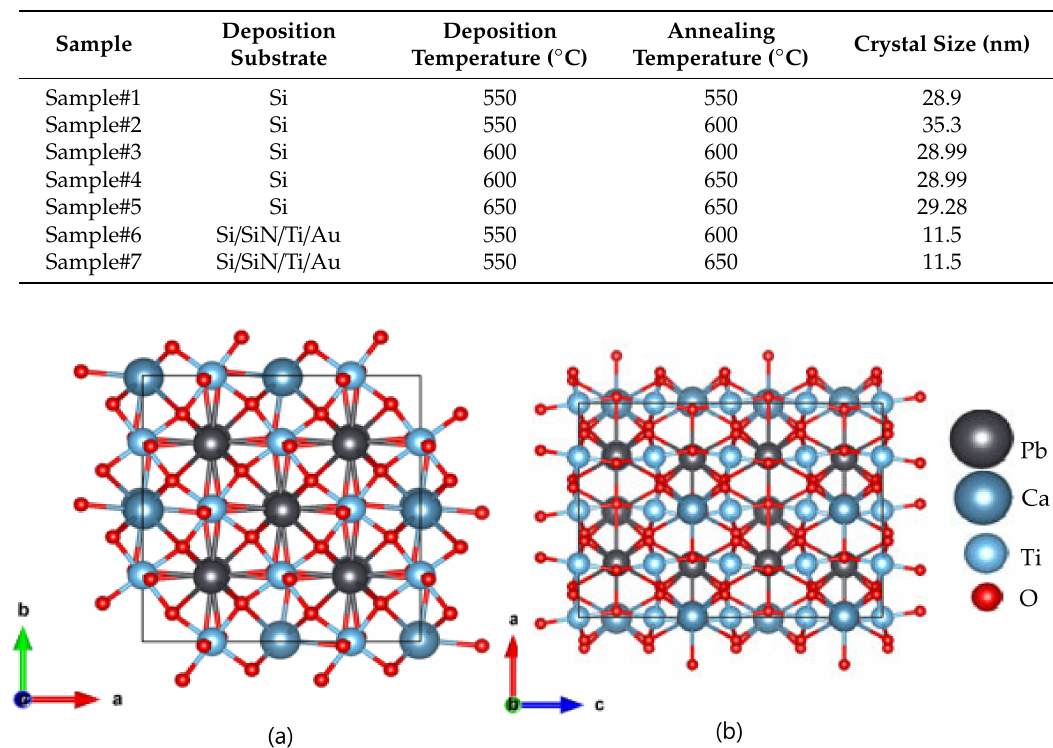
Figure 6. Optimized atomic structure of (Pb 0.593 Ca 0.406 ) TiO 3 films. ( a ) Side view; ( b ) Top view.